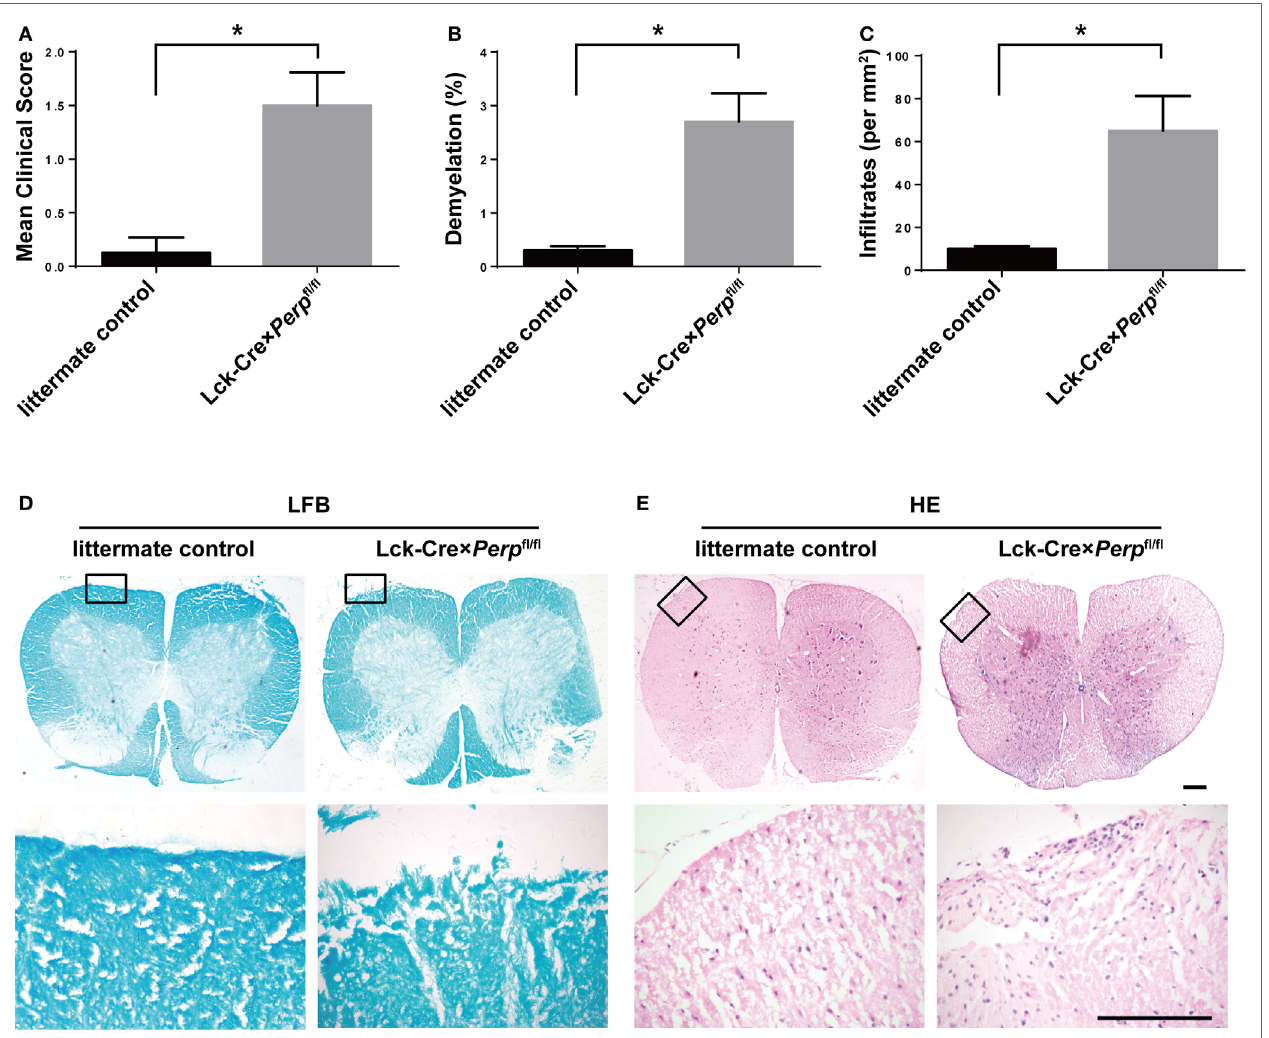
FigUre 6 | Aged Lck-Cre × Perp fl/fl mice exhibit mild experimental autoimmune encephalomyelitis (EAE)-like symptoms. (a) The EAE scores of aged Littermate control and Lck-Cre × Perp fl/fl mice ( n = 8 per group, 10 months of age) were calculated. The mice were perfused after symptom onset and their spinal cord tissues were dissected, fixed, and stained with LFB (D) and H&E (e) . The number of lesions with demyelination (B) and infiltrates (c) were quantified in three spinal cord tissue sections of each mouse. Data are representative images or expressed as the mean ± SEM of each group. Scale bar, 200